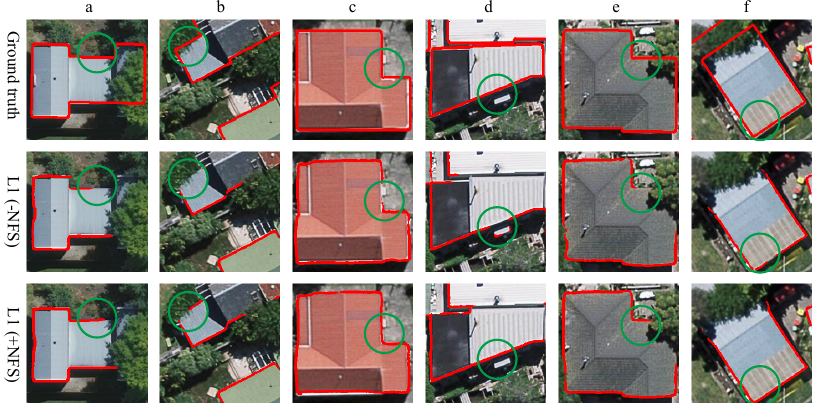
Figure 9. Representative results of extracted outlines from model trained by L1 loss with/without nearest feature selector (NFS). Backgrounds, red lines, and green circles represent aerial input, predicted outline, and focused area, respectively. Selected results are denoted as ( a – f